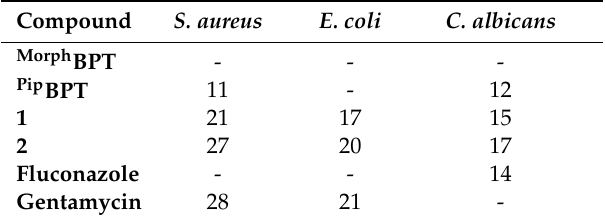
Table 8. Inhibition zones at 200 µ g of the tested compounds by agar well di ff usion method. Compound